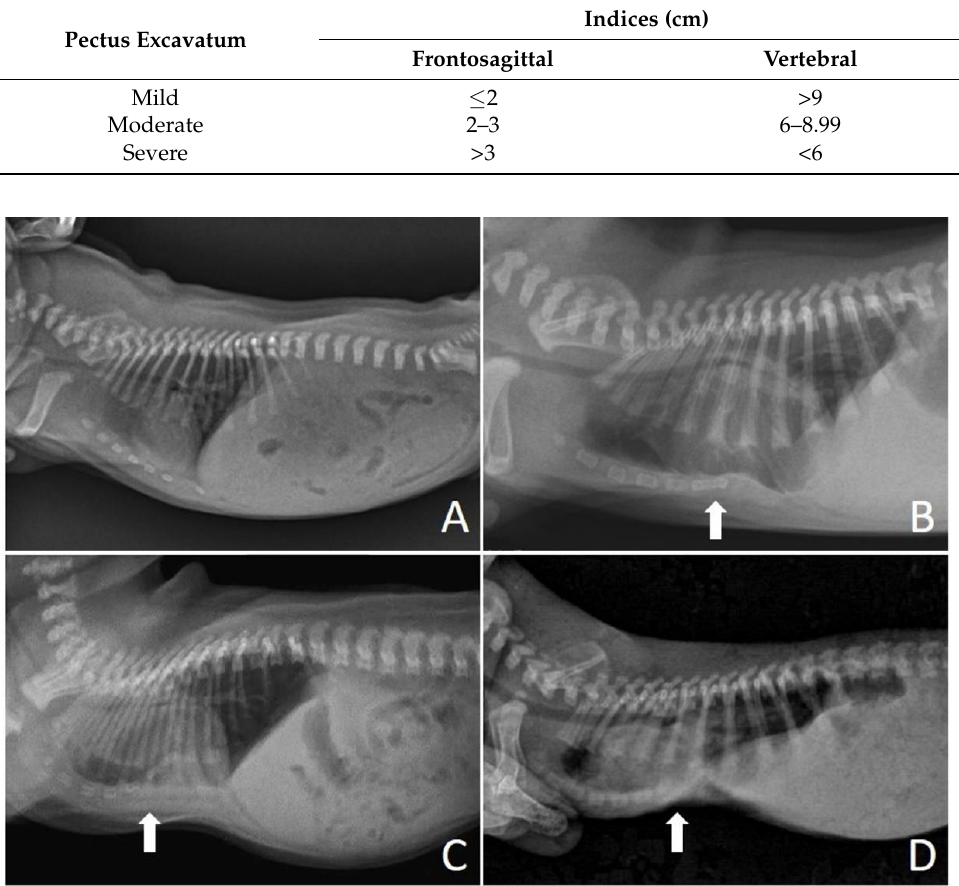
Table 2. Classification of pectus excavatum in dogs and cats based on frontosagittal and vertebral thoracic indices [16]. Indices (cm) Pectus Excavatum